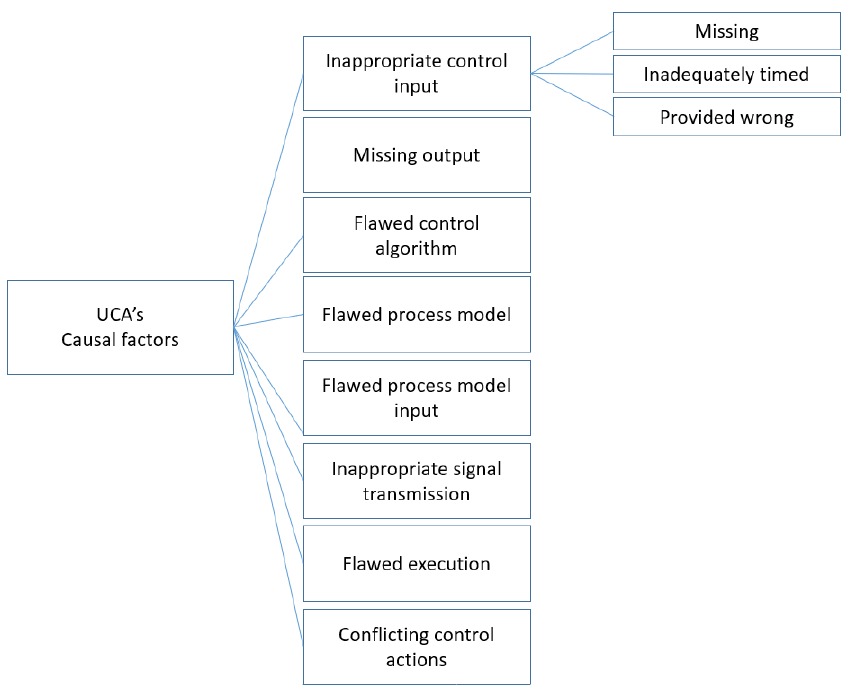
Figure 3. Causal factors’ categories.